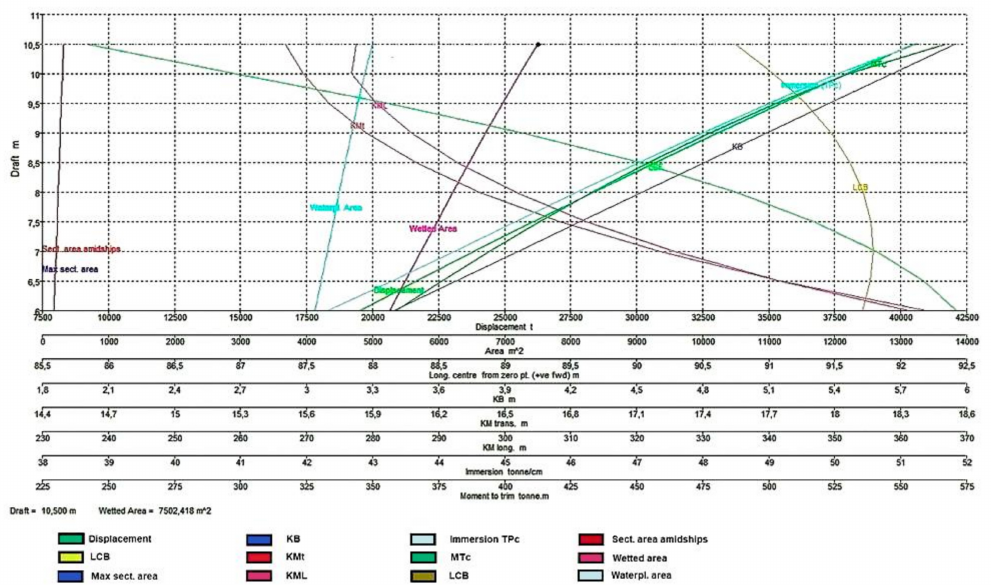
Figure 4. Diagram with hydrostatic curves of the observed container vessel for a block coe ffi cient value of 0.6 at maximum draft. Source: data obtained by